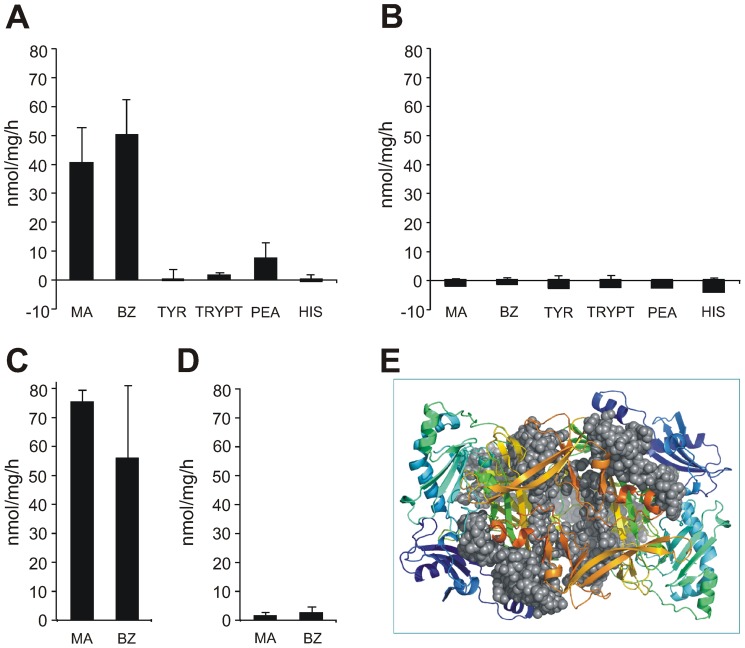
Enzymatic activities of the two VAP-1 isoforms.The SSAO-activity and substrate specificities of VAP-1 and VAP-1Δ3 were defined by a fluorometric assay from lysed transfectants. (A) HEK293 cells transfected with VAP-1. (B) HEK293 cells transfected with VAP-1Δ3 (C) HUVECs infected with VAP-1 (D) HUVECs infected with VAP-1Δ3. The final concentrations of all substrates were 1 mM. MA methylamine; BZ benzylamine; TYR p-tyramine; TRYPT tryptamine; PEA 2-phenylethylamine; HIS histamine. The results are expressed as nmol/mg/h+standard deviation (SD) (n = 3). (E) The structure of dimeric VAP-1 (PDB code 1US1; Airenne et al., 2002), viewed from the side of the carboxy-terminus along the two-fold axis. Both monomers are drawn in rainbow colors from blue amino-termini to red carboxy-termini. The amino acids missing from VAP-1Δ3 (aa 634-761) are illustrated as gray spheres of different shades. The picture was generated with PyMol [54].